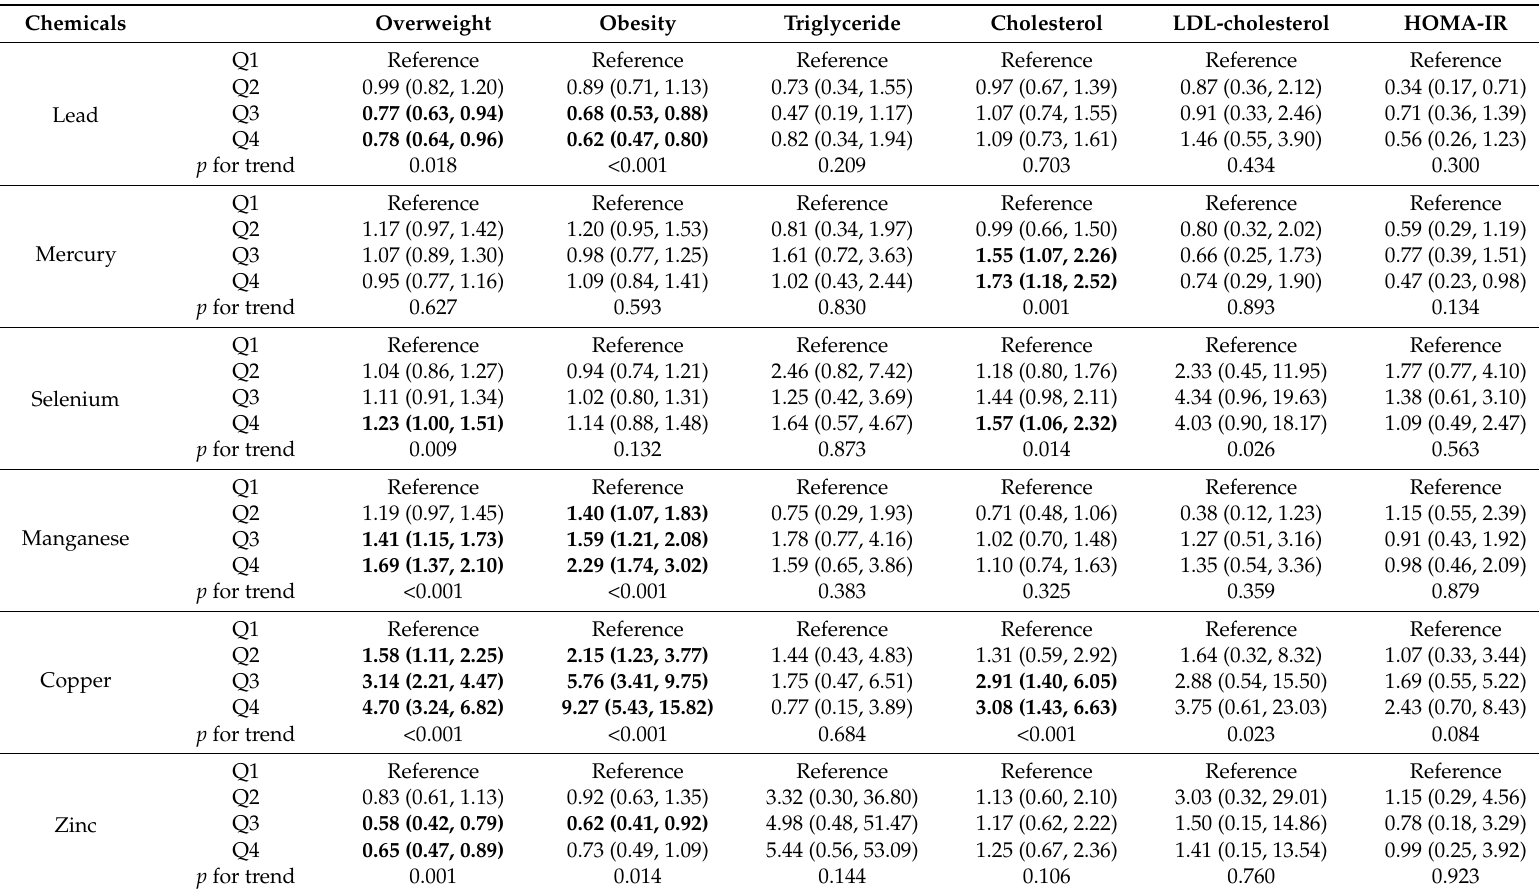
Table 2. Adjusted odds ratios (ORs) (95% CIs) for obesity levels and selected serum metabolites by exposure quartile for serum